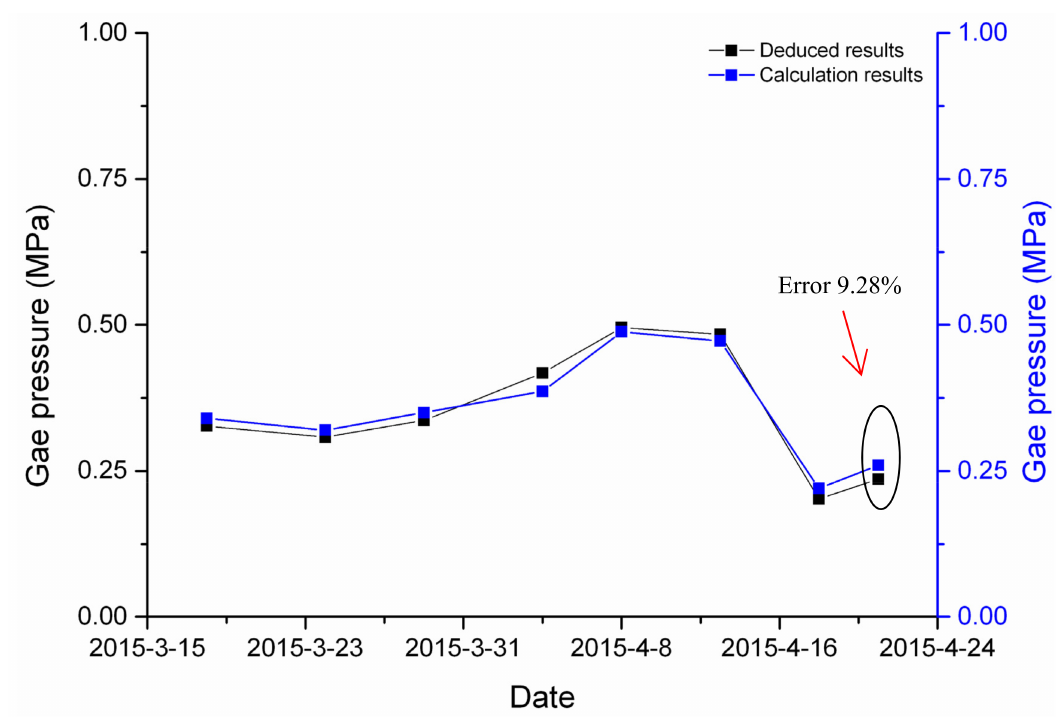
Figure 5. Comparison between calculation and deduced gas pressure